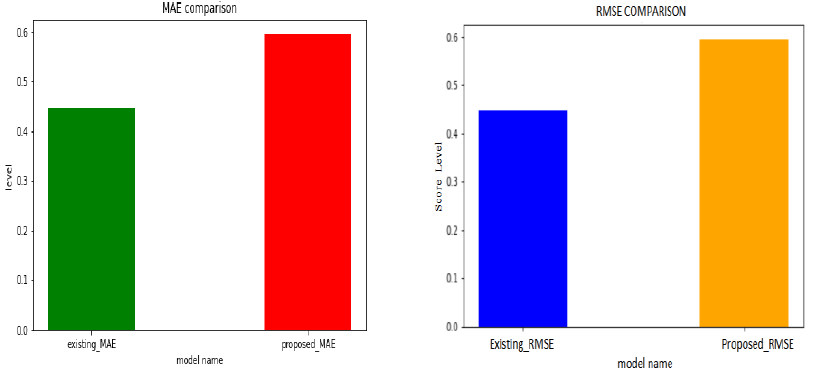
Figure 5. Performance evaluation of MAE and RMSE.